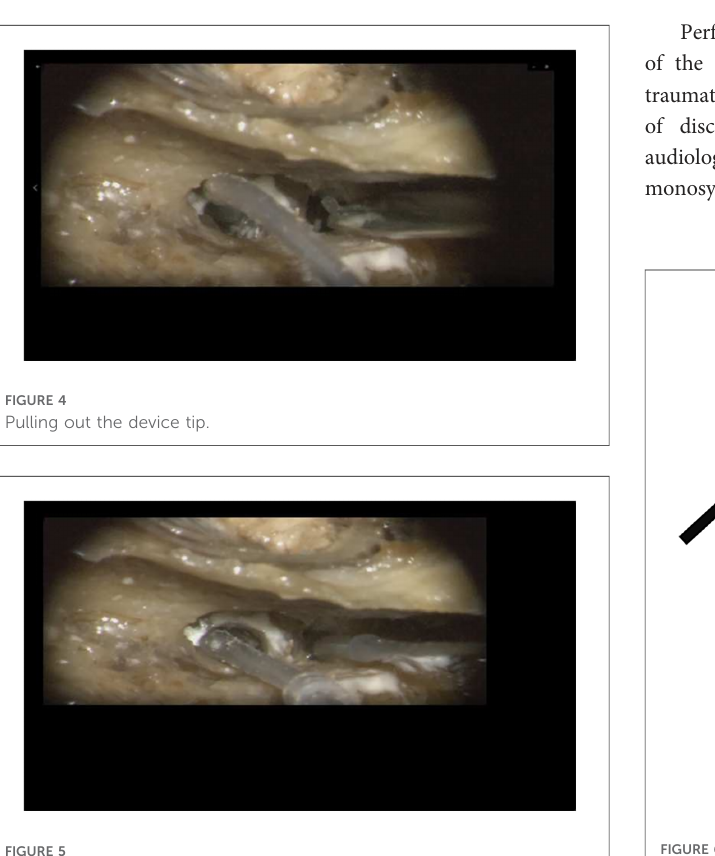
FIGURE 6 Schematic insertion of the device through the tumor